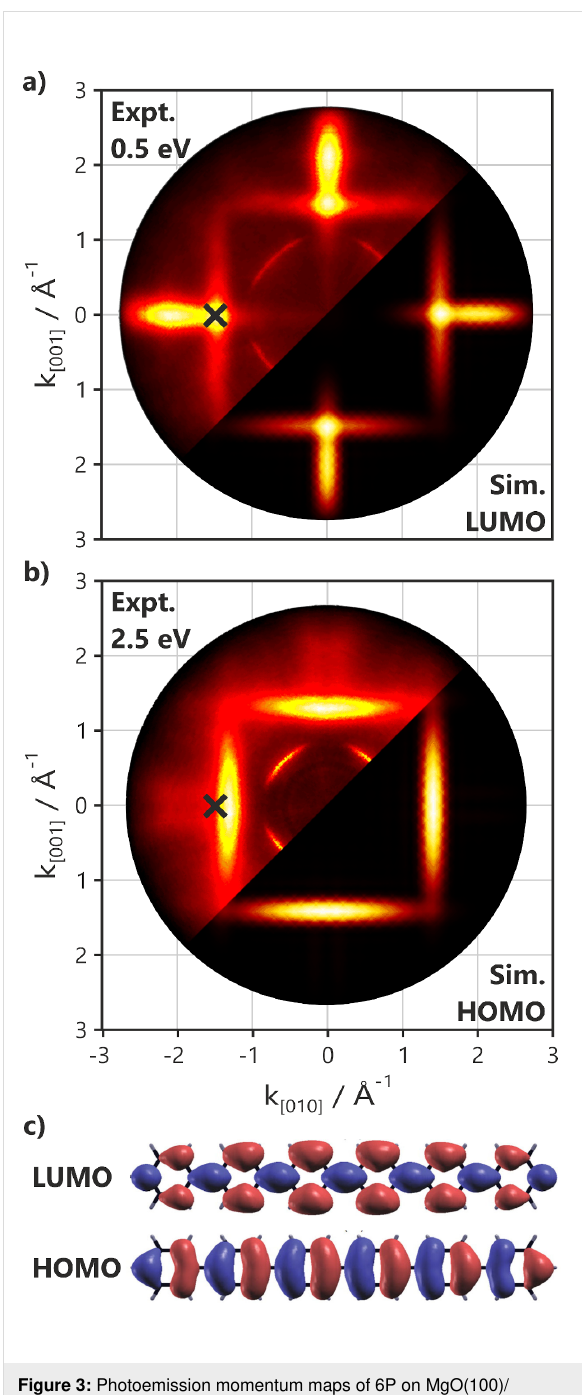
Figure 3: Photoemission momentum maps of 6P on MgO(100)/ Ag(100) at energies of (a) 0.5 eV and (b) 2.5 eV below E F , measured with a photon energy of 35 eV and at an incidence angle of 40°. The experimental maps (top left of a and b) are shown in comparison to the maps calculated from the density functional theory orbitals (c) for two orthogonally oriented planar 6P molecules of the LUMO (bottom right of a) and the HOMO (bottom right of b). The geometry for the maximum LUMO intensity used in the following angle-resolved ultravio- let photoemission spectroscopy experiments is marked with crosses. Deviations from the simulations for isolated molecules are a result of MgO and Ag(100) sp-band emissions. Films of 6P were grown and measured at room